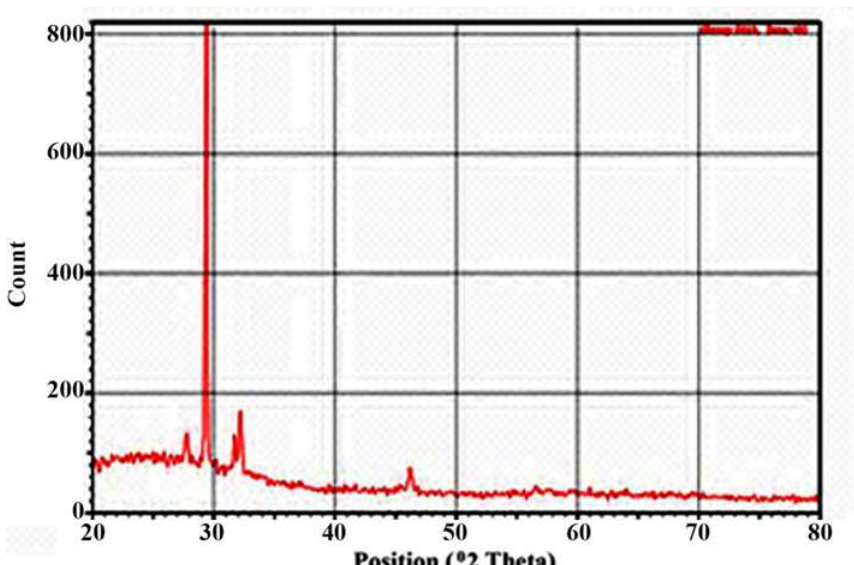
Figure 4. XRD pattern of biosynthesized AgNPs using S.pyogenes bacterium .